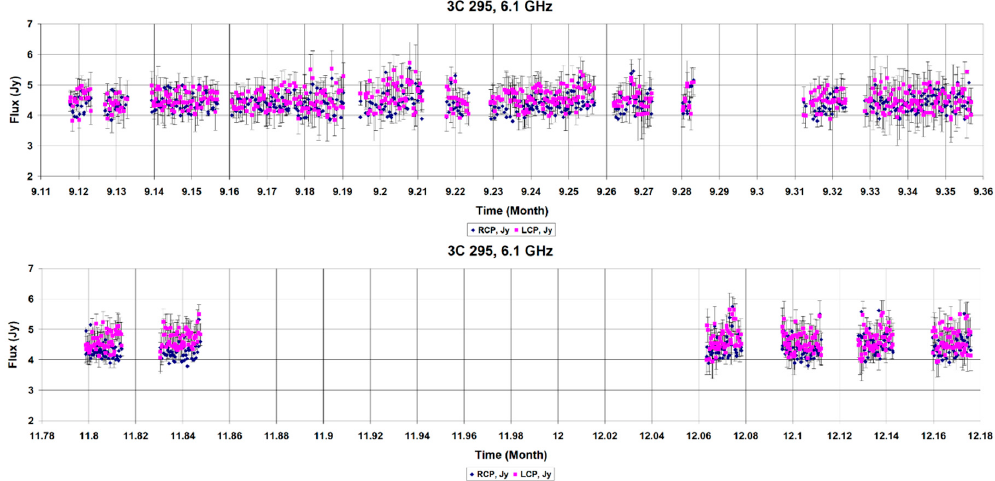
Figure 2. Plots of stability in the flux density of the calibration radio source 3C 295 based on observations in September and November–December 2019, at a frequency 6.1 GHz.